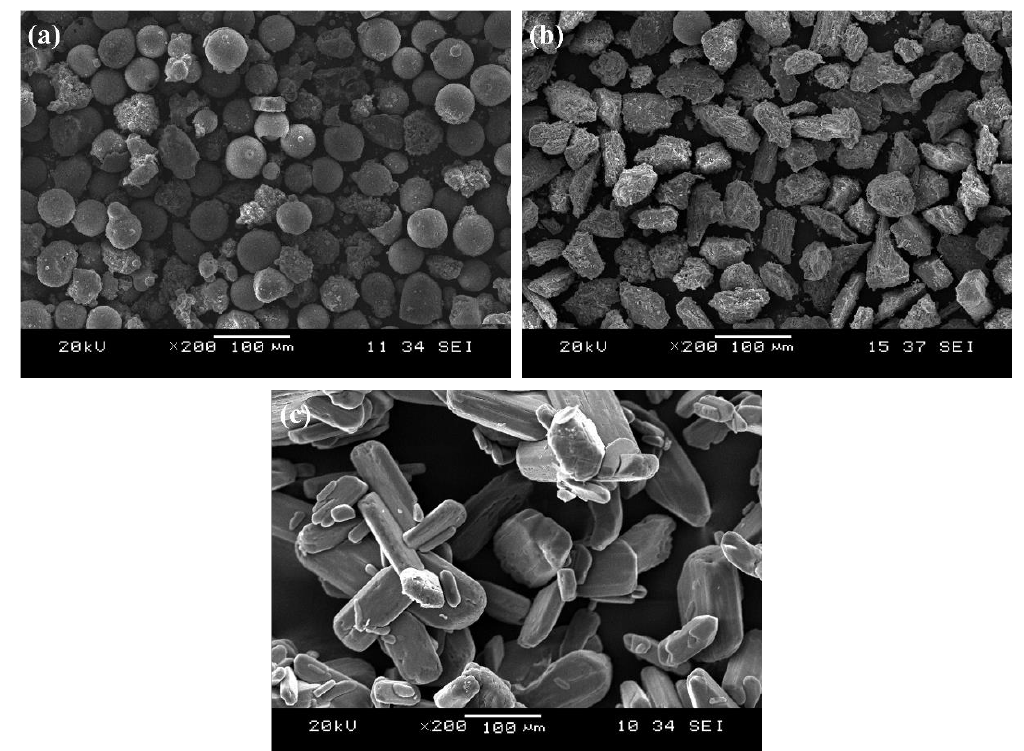
Figure 2. SEM micrographs of ( a ) FA, ( b ) LFS, and ( c ) borax decahydrate.